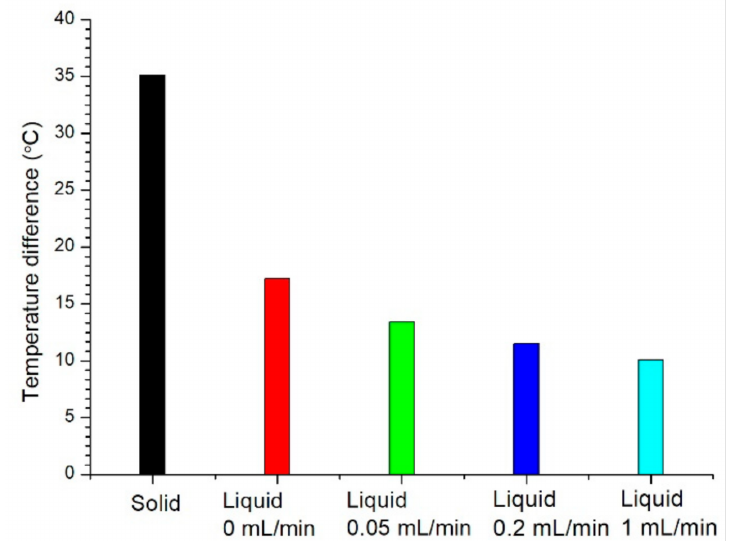
Figure 8. Temperature differences of the LED bottom between initial and 480 min using solid conductor and graphene solution with various flow